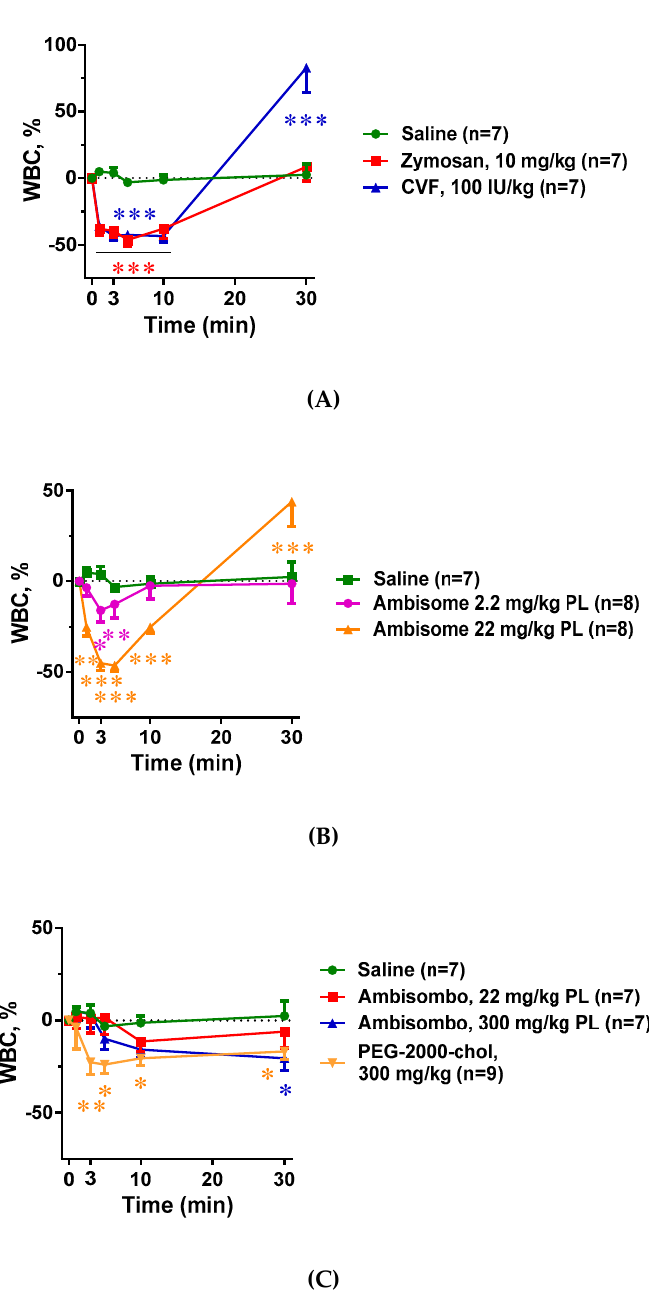
Figure 4. Effects of direct complement activators ( A ), amphotericin B-containing ( B ), and empty liposomes ( C ) on plasma white blood cell (WBC) counts in anesthetized rats. The doses and number of animals are specified in the keys. The data show percentages of change relative to baseline (t = 0 min), mean ± SEM. Statistical analysis was performed using two-way repeated measurements ANOVA followed by Dunnett’s multiple comparisons post-hoc test. Significant differences (* = p < 0.05; ** = p < 0.01; *** = p < 0.001) are shown relative to the group treated with saline.